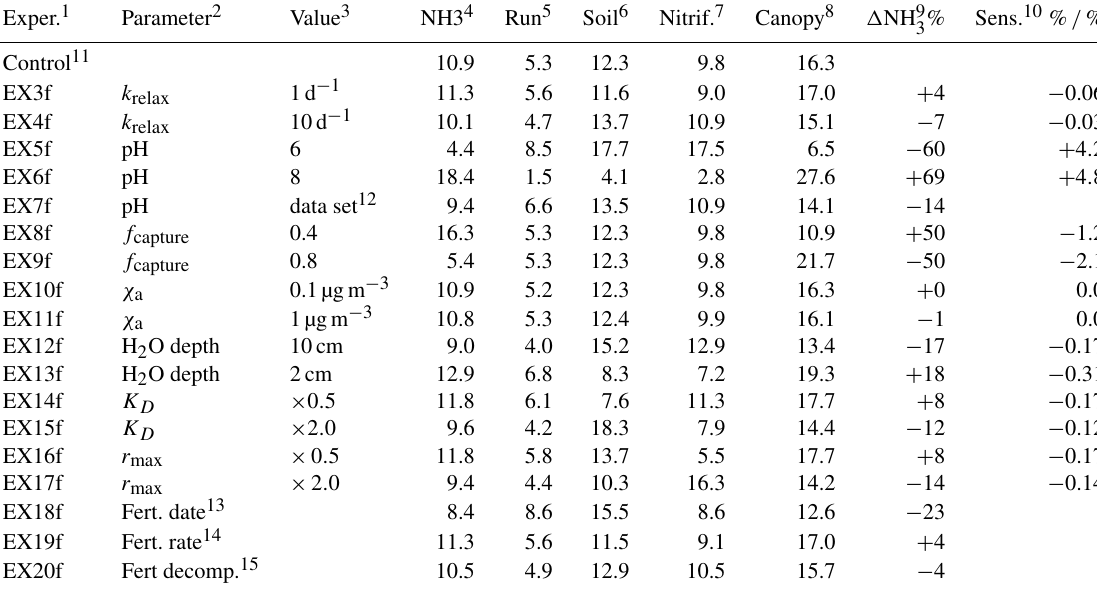
Table 2. Fertilizer sensitivity tests. Exper.